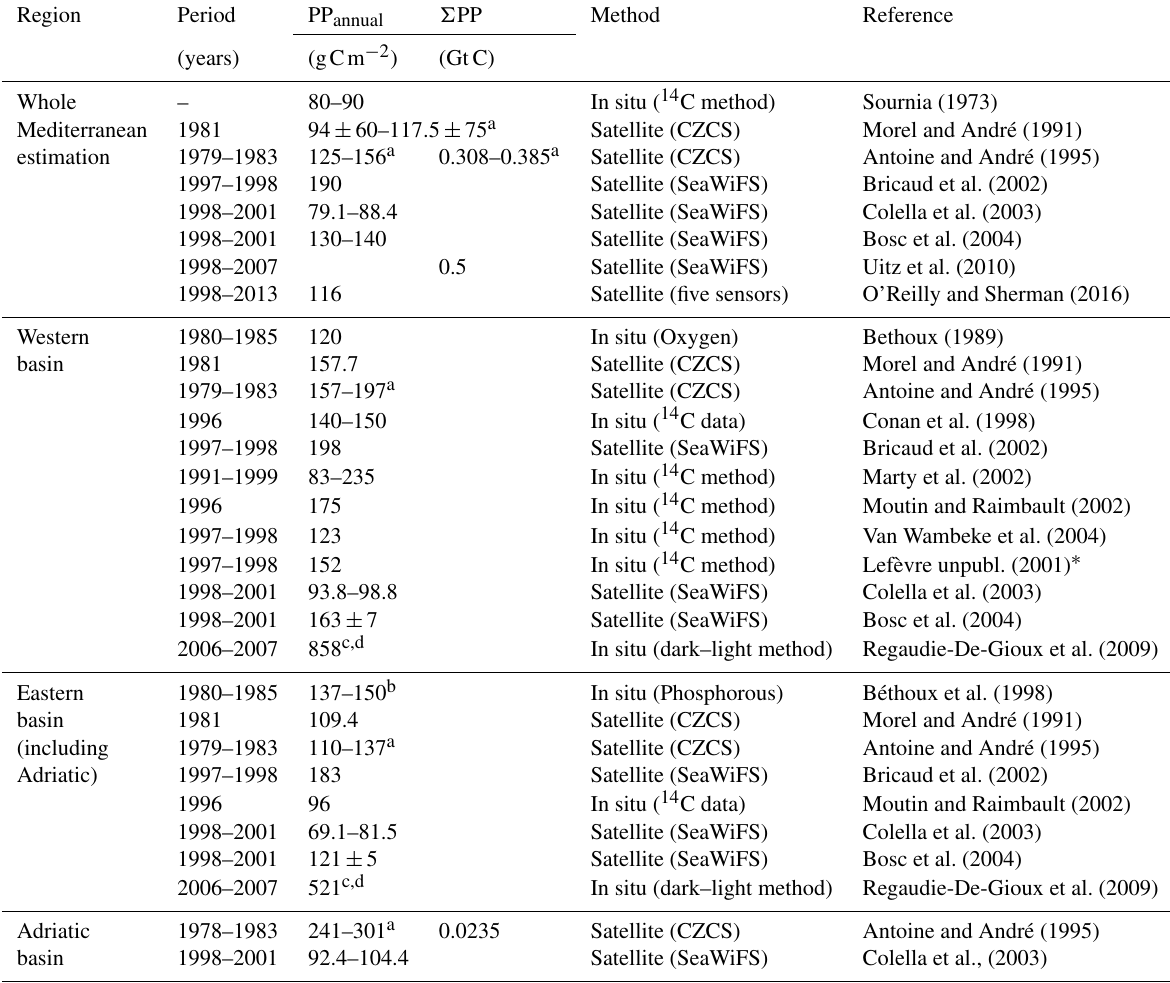
Table 3. Compilation of published values of PP annual and (cid:54) PP for the different Mediterranean basins.